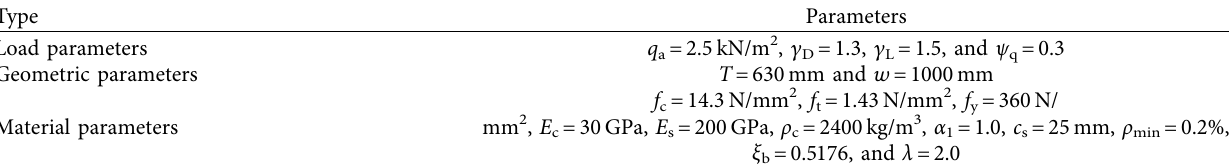
Table 3: Design parameters for RC stair slabs.